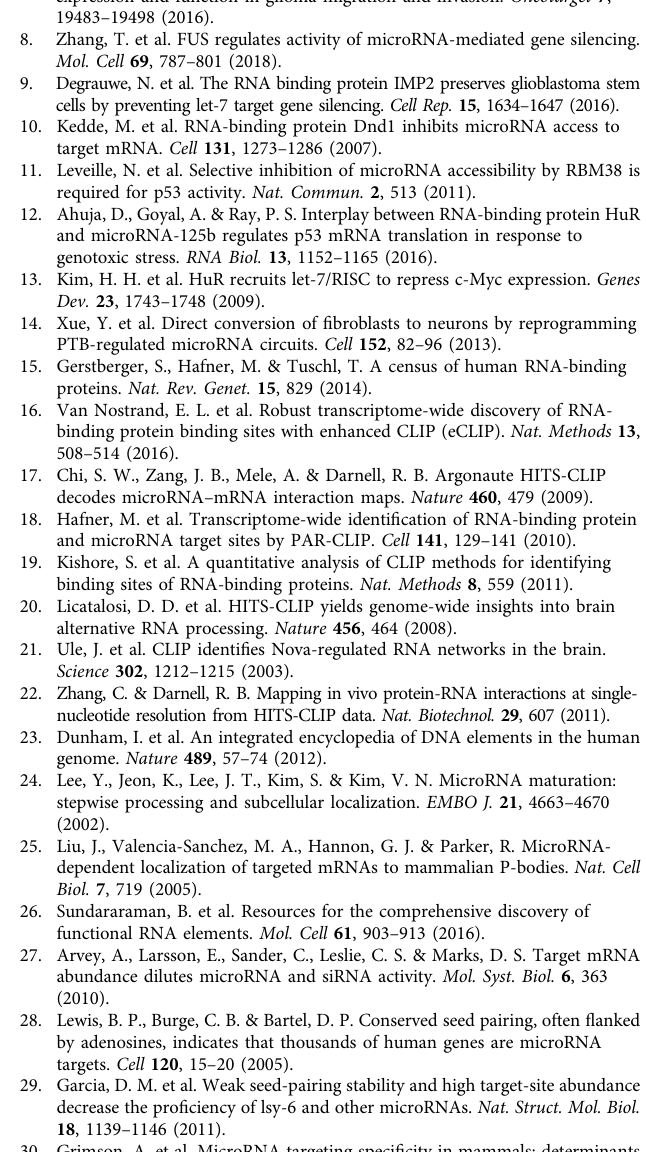
Fig. 9 Evolutionary perspective on the regulatory impact of RBPs on miRNA targeting. a , Fraction of miRNA target sites (MTSs) that have RBP-binding sites (RBSs) in their close proximity. 7, 8mer MTSs of miRNA families conserved across the vertebrates were collected 47 . The fraction of MTSs including ≥ 1 RBSs within 50 or 100 nt fl anking regions was calculated using the binding information of RBPs pro fi led in HepG2 (top left). Based on the calculated fractions for subsampled RBPs (solid dots), we fi tted a regression curve (solid line) to extrapolate the analysis to a larger number of considered RBPs (dashed line). The same analysis was repeated for conserved (PhyloP 62 > 0.0, top middle) and highly conserved MTSs (PhyloP > 2.0, top right). Similar analyses were performed for RBPs pro fi led in K562 (bottom). b Co-occurrence of evolutionarily conserved MTSs and RBSs in various human tissues. By utilizing transcriptome data of 54 tissues 48 , highly expressed RBPs and miRNAs were collected for each tissue. For each conserved miRNA highly expressed in a given cell, 7, 8mer MTSs were collected and RBP-binding signals near the MTS were measured within 50 nt fl anking regions. The magnitudes of RBP-binding signal were compared between the chosen MTSs and their control MTSs by using two-sided Wilcoxon ’ s rank-sum test after correction of confounding features (Supplementary Fig. 8c). Statistical signi fi cances after multiple test correction via the false discovery rate are displayed. Upward and downward directions of the y-axis indicate co-occurrence and mutually exclusive occurrence between MTSs and RBSs, respectively. c Proposed model of MT that takes >1,500 RBPs into account. For an MTS readily accessible to AGO, other RBPs would not affect MT ef fi cacy (top row) and such cases are well explained by the currently accepted model of a ternary interplay between AGO, miRNA, and mRNA target. However, as our analysis indicated that in a vast majority of cases ≥ 1 RBSs are located close to the MTS, our proposed model that additionally takes RBSs of >1,500 3 ′ UTR- binding RBPs into consideration would better explain MT (bottom four